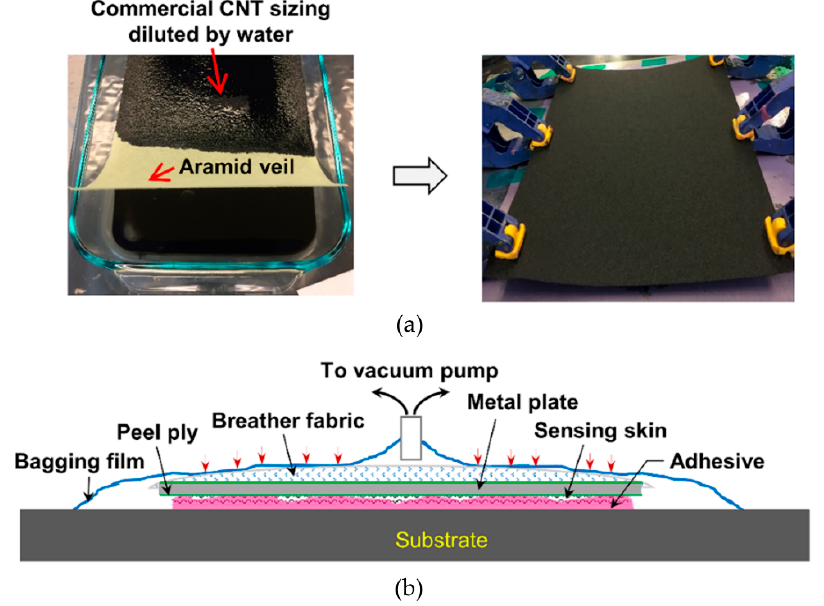
Figure 2. Fabrication process of proposed CNT fatigue sensor: ( a ) dipping aramid veil into CNT sizing agent and drying in the oven; ( b ) implementation of vacuum bagging technique to bond sensing layer to metal substrate.